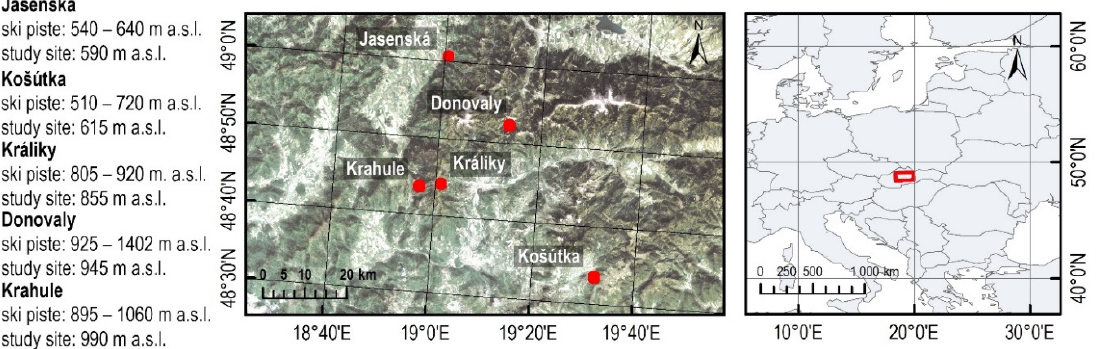
Figure 1. Ski centers’ elevations and locations in Central Slovakia and Central Europe.